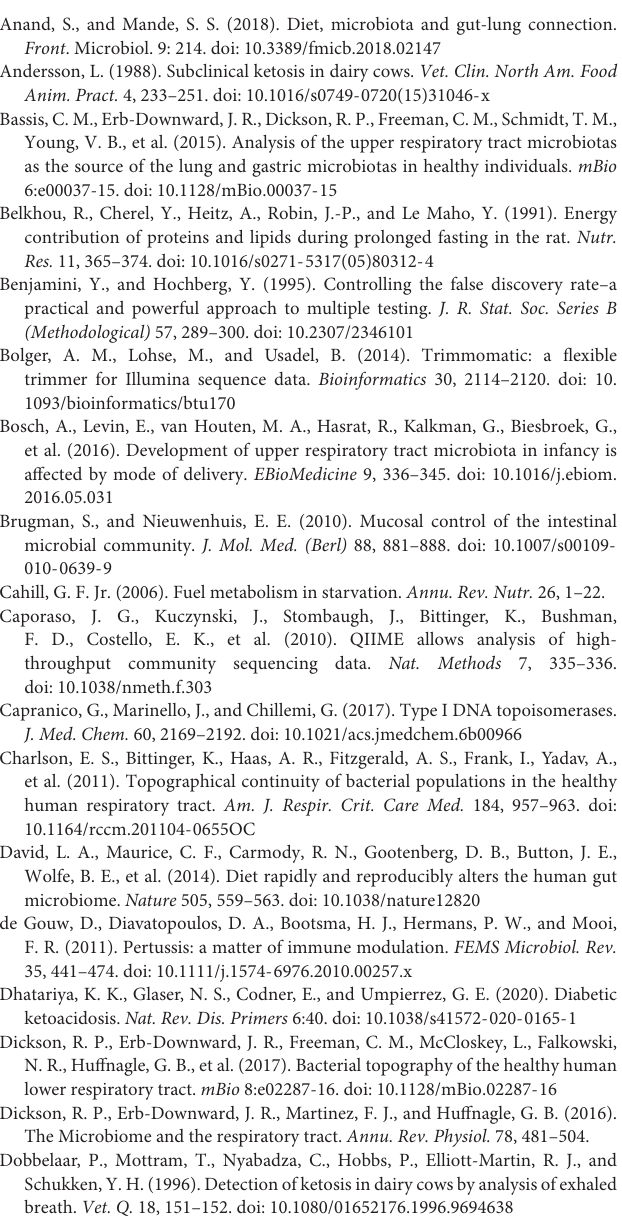
Supplementary Table 6 | Detailed relative abundance data of detected viruses of each group. Supplementary Table 7 | Detailed relative abundance data of top 50 species significantly changed species. Supplementary Table 8 | (A) Detailed relative abundance data at the genus level of each sample. (B) Detailed statistical information of contigs/scaffolds. Length of N20/50/90: arranges all the assembled contigs/scaffolds sequences in order of length from long to short and then added from long to short. When the